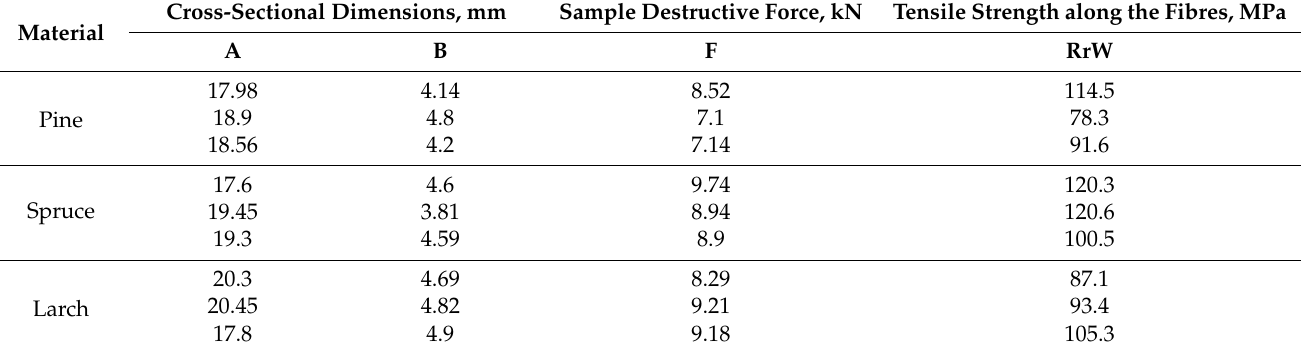
Table 4. Tensile testing along the fibres of respective cycle 3